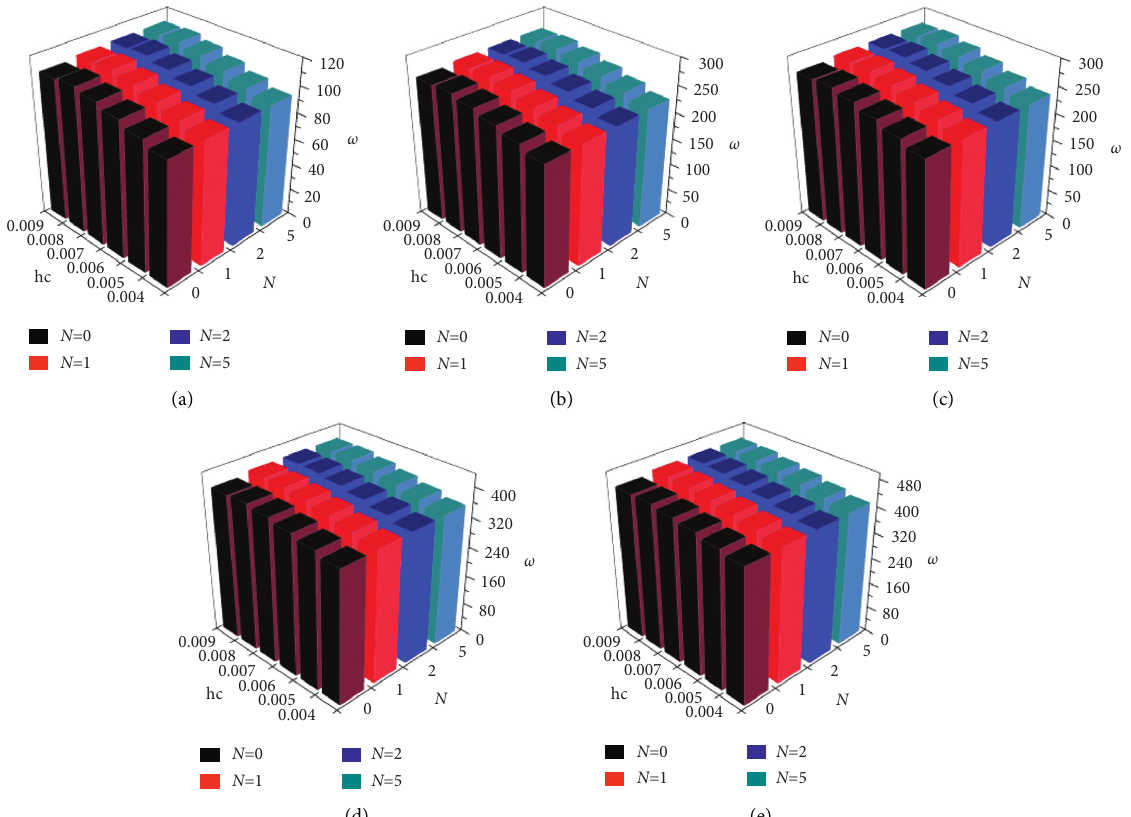
Figure 6: Type B first five natural frequencies ω of simply supported FGM sandwich plate: (a) 1 st natural frequency, (b) 2 nd natural frequency, and (c) 3 rd natural frequency.